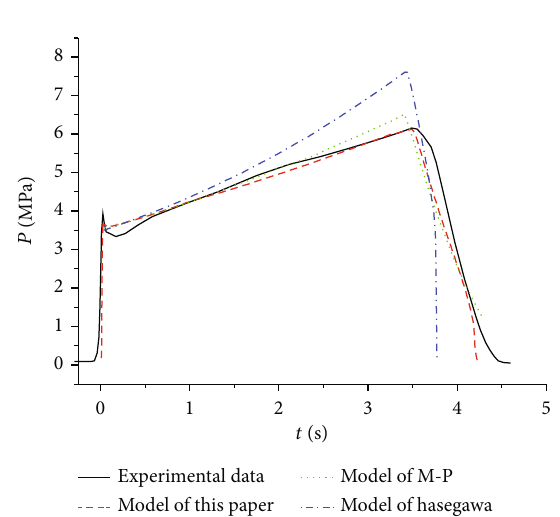
Figure 11: Pressure history of motor B.